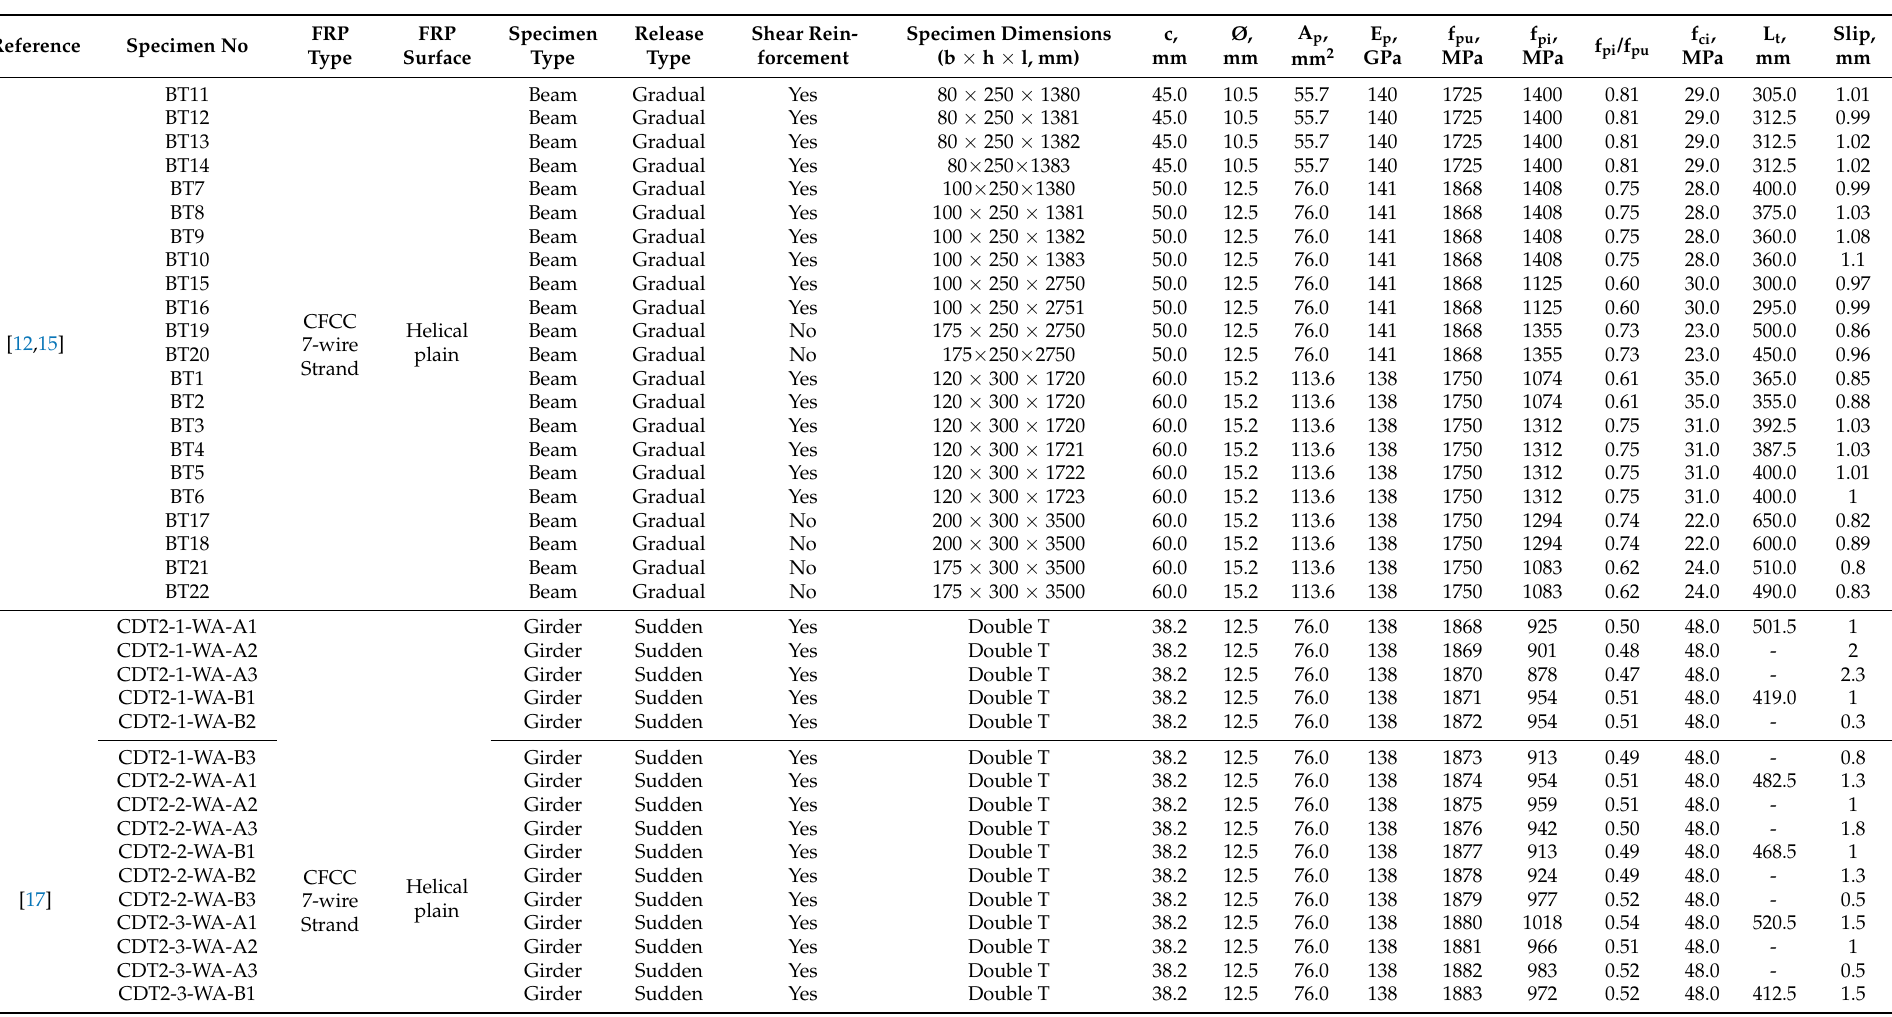
Table A1. Experimental parameters of specimens with pretensioned CFCC